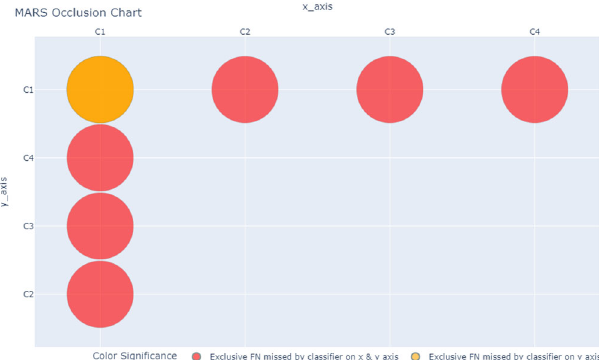
Figure3.MARSOcclusionChart,comparingcount(representedbybubbleradius)oftarget-classobservations (False Negatives) exclusively missed by classifiers C1-4 and the pairwise classifier combinations. Bubble size is proportional to Occlusion score: the larger the bubble, the higher the classifier(s) Occlusion score.